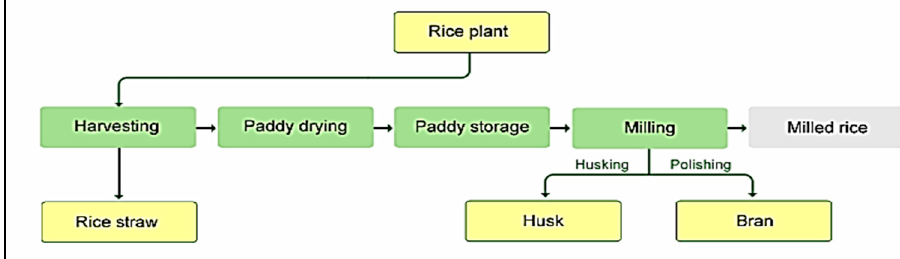
Figure 8. Proposed rice logistics network.